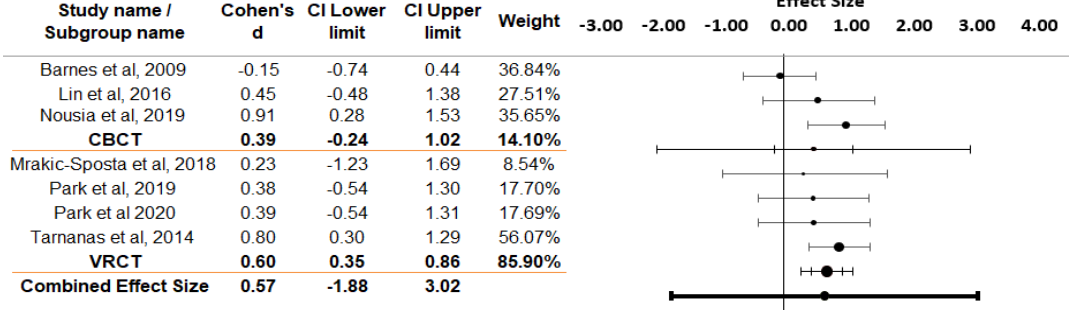
Figure 5. Forest plot of visuospatial skills (VS).